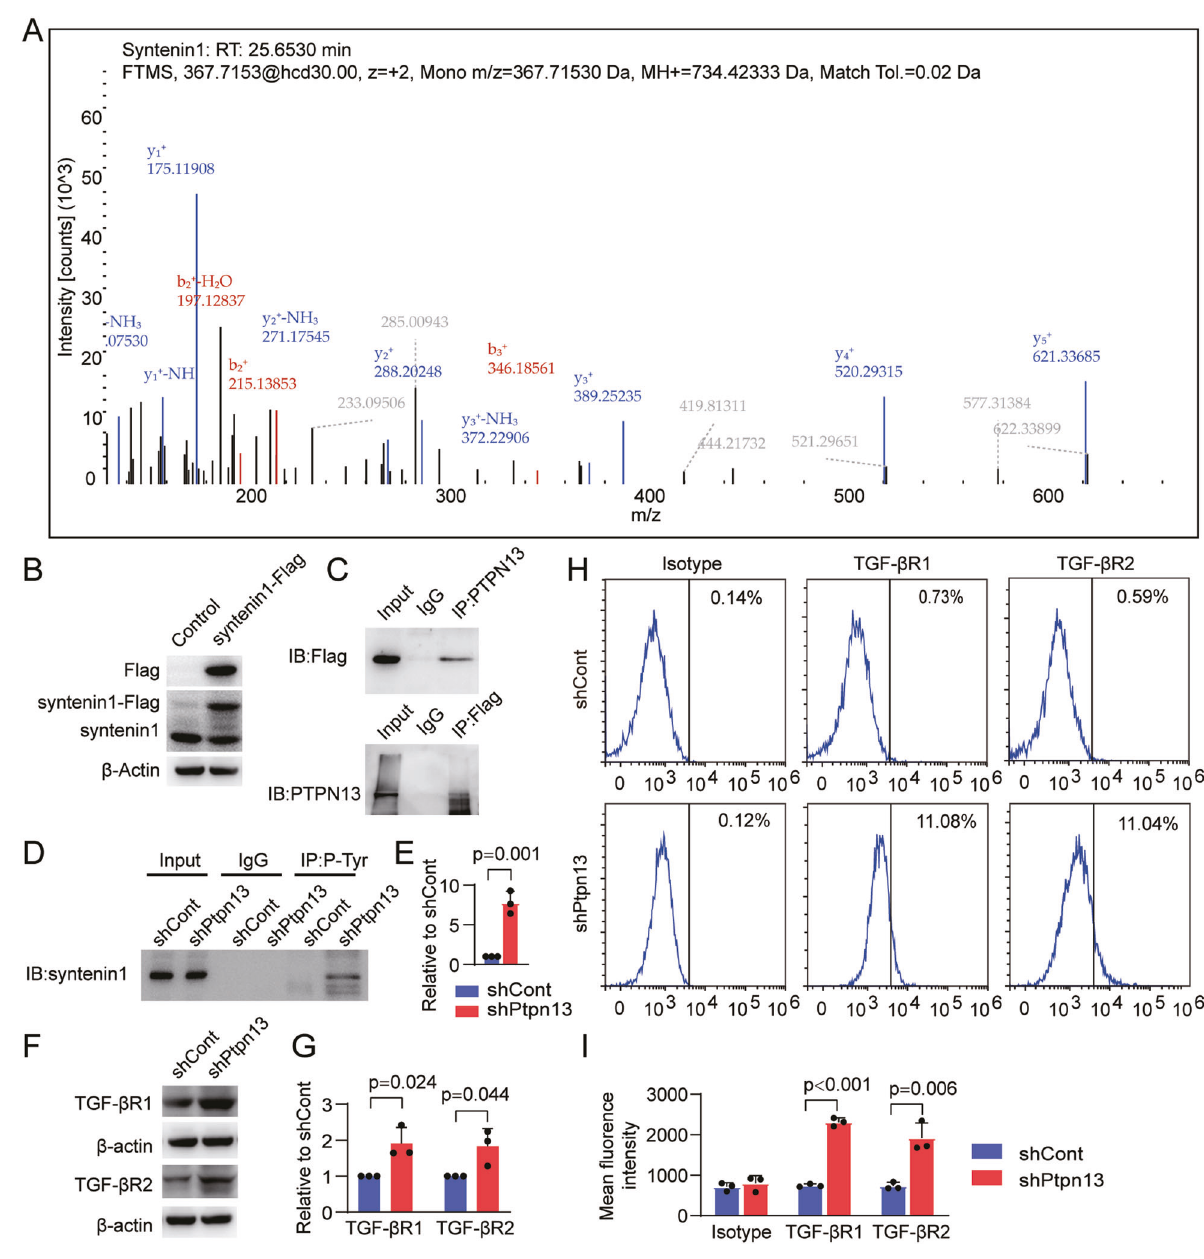
Fig. 5 PTPN13 dephosphorylates syntenin1 to promote TGF- β receptor internalization. PTPN13 binding syntenin1 in iRPE cells were identi fi ed by A mass spectrometry and con fi rmed by B , C Western blotting. Phosphorylation of syntenin1 was detected by D anti- phosphorylated-Tyr antibody CO-IP assay and E quantitative analysis ( n = 3). The expression levels of TGF- β R1 and TGF- β R2 in shCont-iRPE and shPtpn13-iRPE cells were detected by F Western blotting, G quantitative analysis ( n = 3). The expression levels of TGF- β R1 and TGF- β R2 on cell membranes of shCont-iRPE and shPtpn13-iRPE cells were detected by H fl ow cytometry and I quantitative analysis of mean fl uorescence density ( n = 3). Results are expressed as mean ± SD. P value measured by Student ’ s unpaired t